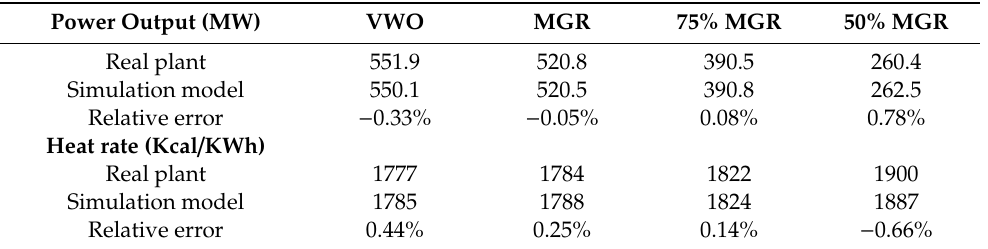
Table 4. Comparison of total output and heat consumption rate with actual power